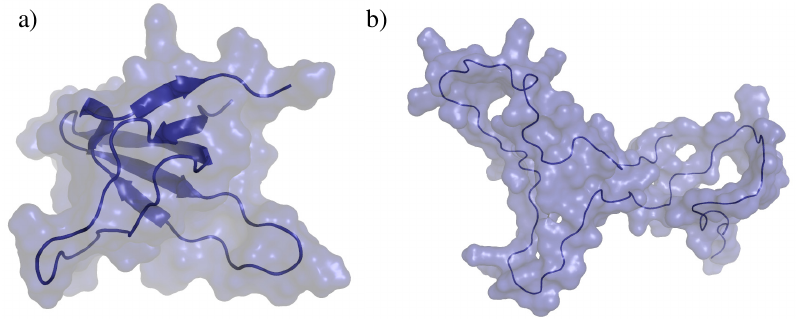
Figure 2. Proteins used for the analysis of the methods: ( a ) SH3 domain; ( b ) Sic1